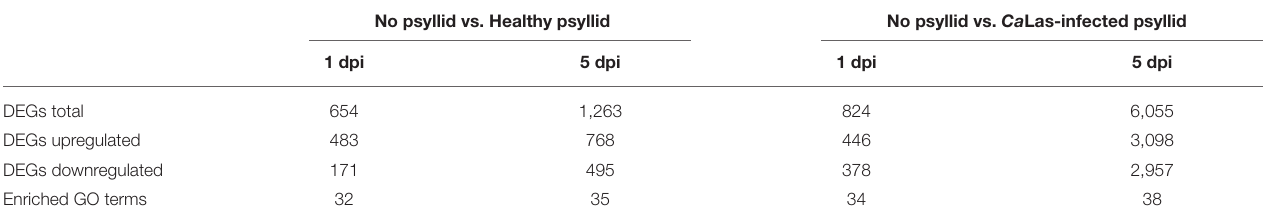
TABLE 2 | Number of DEGs and enriched GO terms of the major biological process classes in the comparisons “No psyllid vs. Healthy psyllid” and “No psyllid vs. Ca Las-infected psyllid” in Valencia orange. No psyllid vs. Healthy